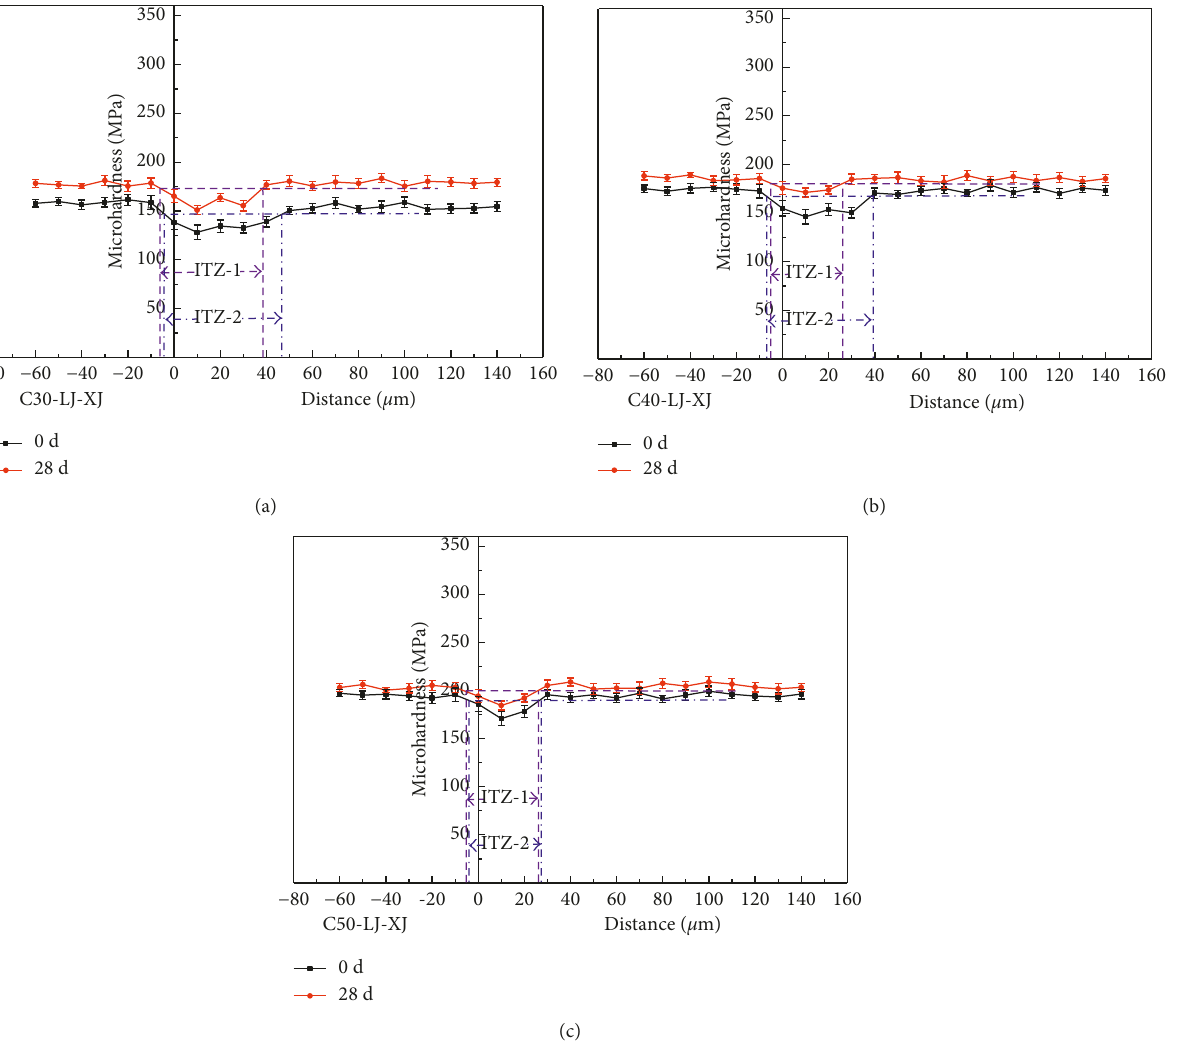
Figure 9: Effect of carbonization on the microhardness of the LJ-XJ interface of recycled concrete: (a) C30 (LJ-XJ); (b) C40 (LJ-XJ); (c) C50